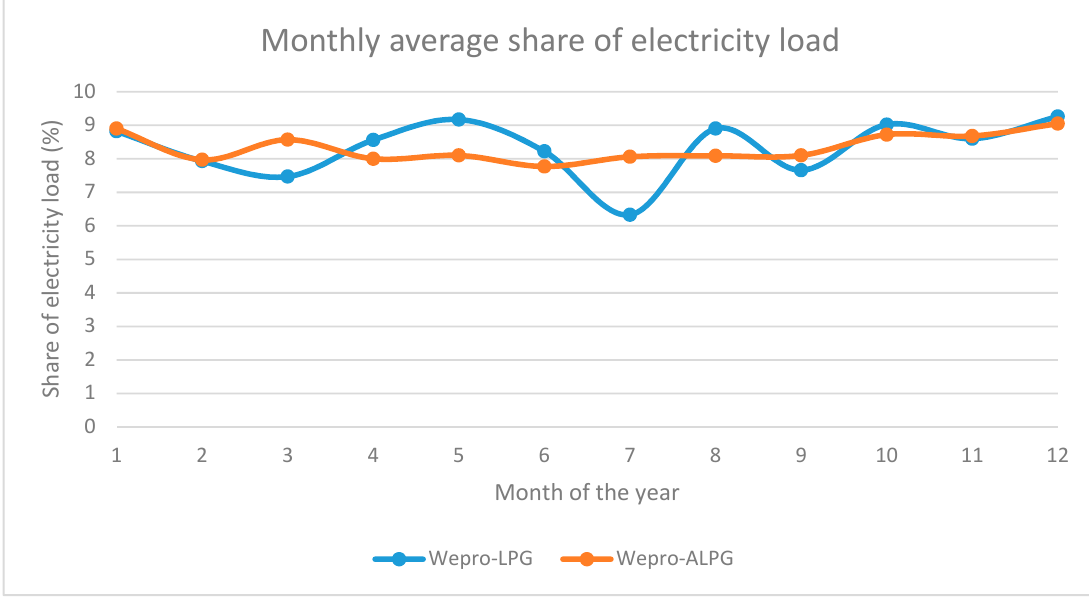
Figure 10. Monthly average electricity load share based on the results of the generated Wepro-LPG and Wepro-ALPG models.